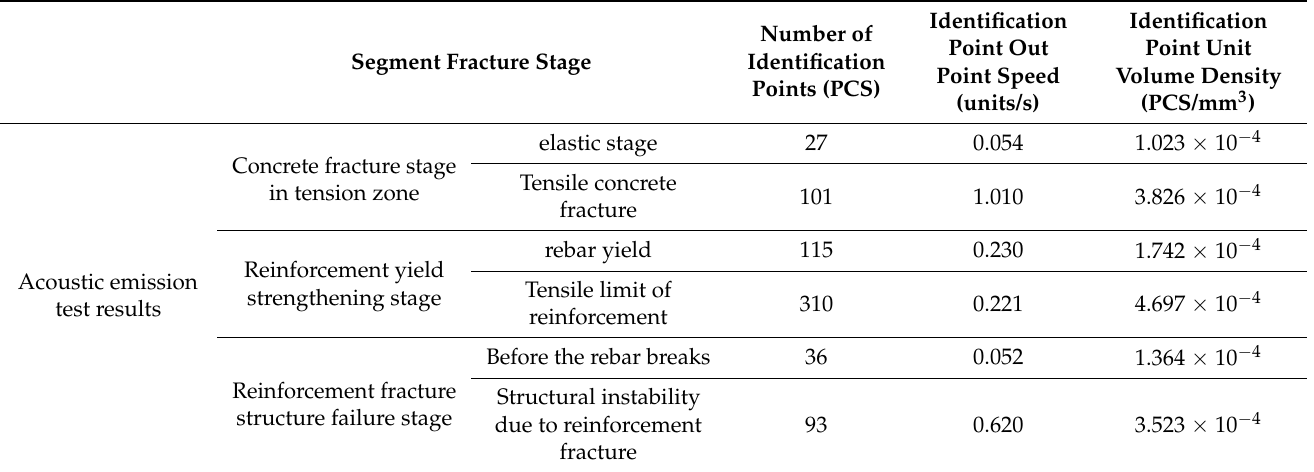
Table 2. Comparison of acoustic emission detection results at different